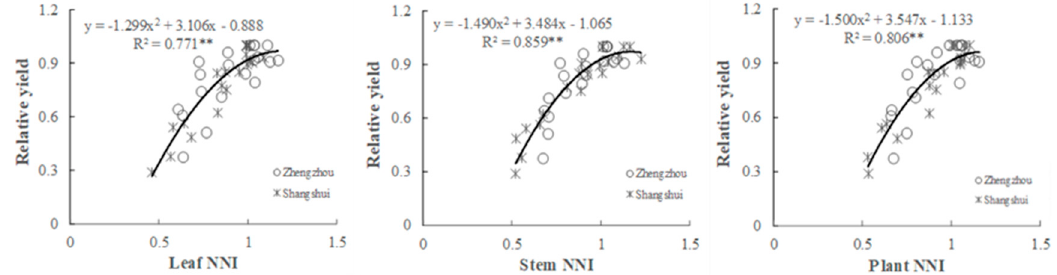
Figure 8. Relationship between the N nutrition index (NNI) and relative yield in winter wheat.